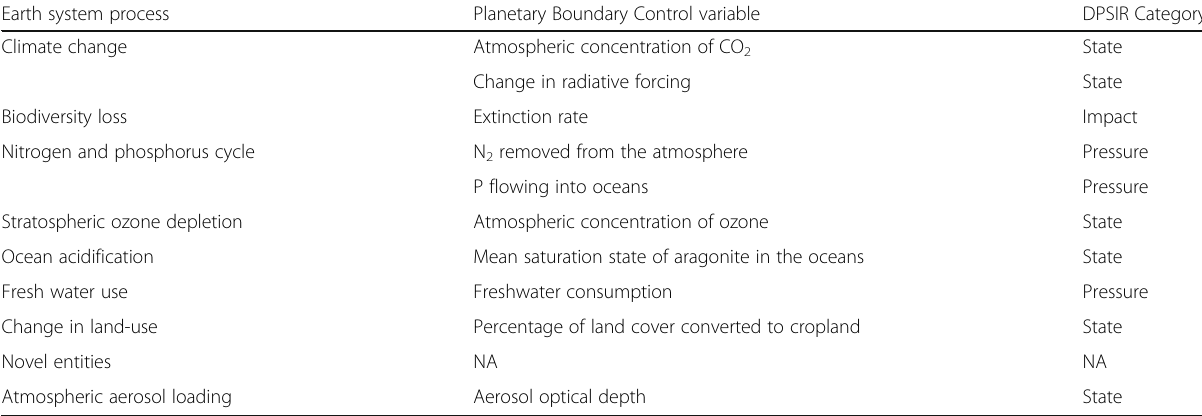
Table 2 Driver-Pressure-State-Impact-Response (DPSIR) classification of the Planetary Boundary control